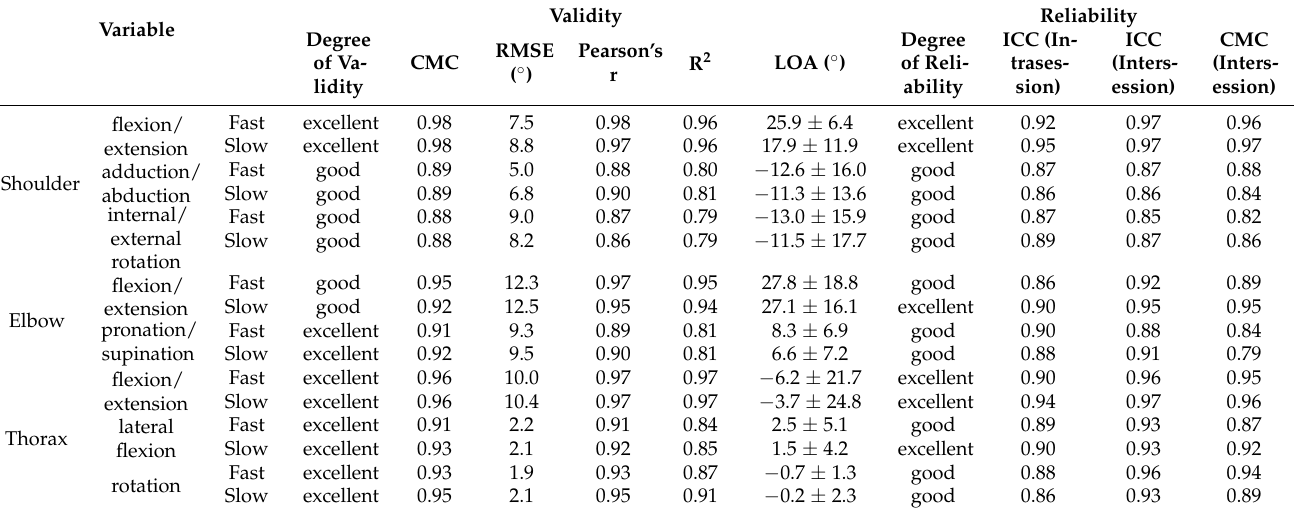
Table 2. The statistical metrics of validity and reliability of the PNS in the complex